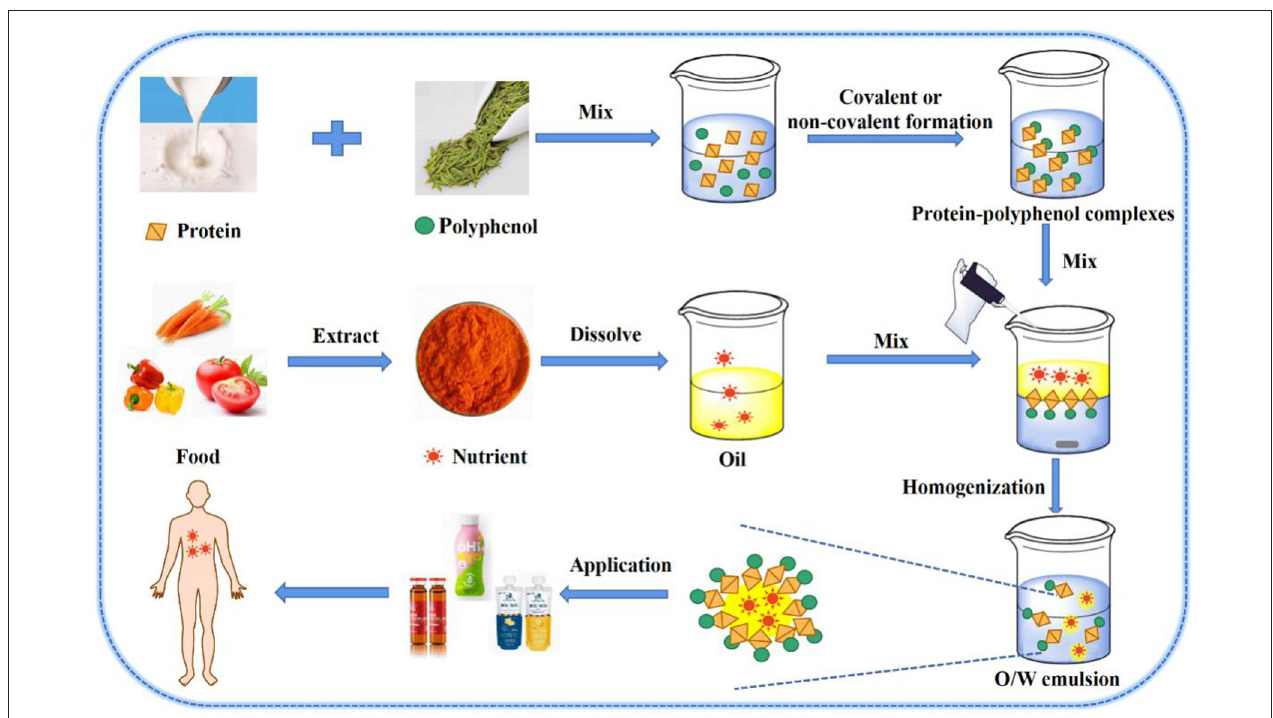
FIGURE 3 | O/W emulsion nutrient delivery system: Protein-polyphenol complexes load nutrients in O/W emulsion.